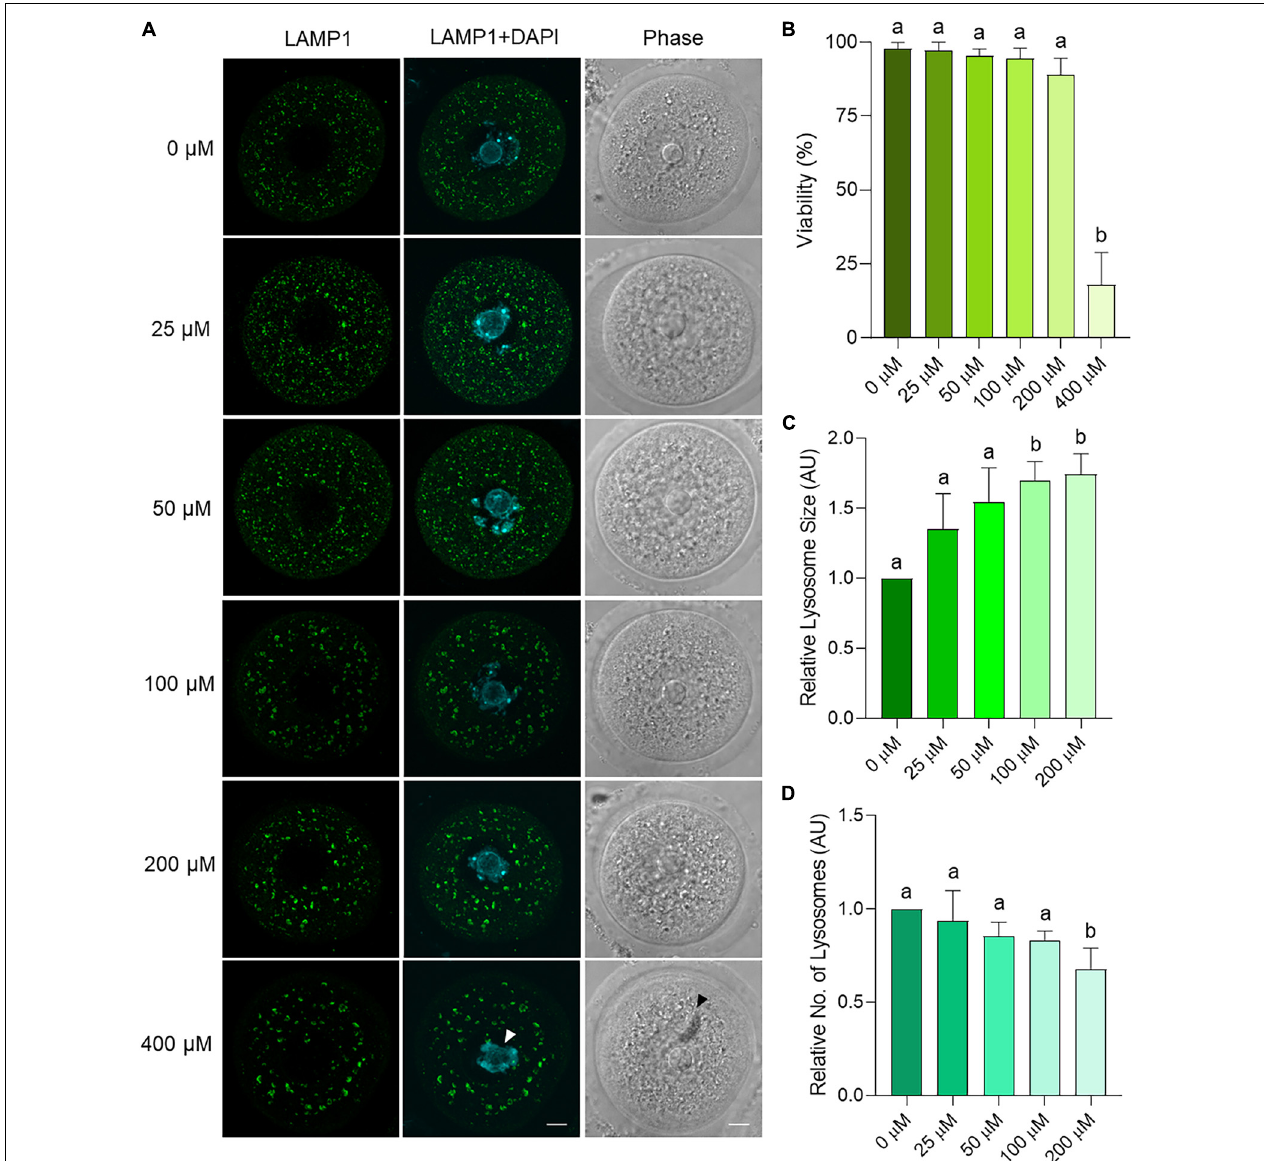
FIGURE 9 | Dose response trial using chloroquine on young mouse oocytes to assess effects on lysosome parameters. Oocytes from young (4–6 weeks old) mice were treated for 6 h with varying concentrations of chloroquine before fixation and labeling with anti-LAMP1 antibodies (green), nuclear counterstaining with DAPI (cyan), confocal imaging (60 × objective), and puncta analysis. Scale bar = 10 µ m. (A) Representative images illustrate the changes in size and number of LAMP1 labeled puncta within oocytes treated with 0, 25, 50, 100, 200, and 400 µ M chloroquine. White arrow indicates reduced chromatin condensation and black arrow indicates cytoplasmic inclusion. (B) Viability of oocytes as the percentage of live, morphologically normal oocytes in each treatment group. (C) Average area and (D) number of lysosomes (LAMP1-staining puncta) as determined through puncta analysis. Data is normalized to the untreated control. Statistical significance ( P < 0.05) between groups is indicated by different letters, n = 3 for all groups except 0 and 100 µ M with n = 6. Statistics not performed on 400 µ M due to low